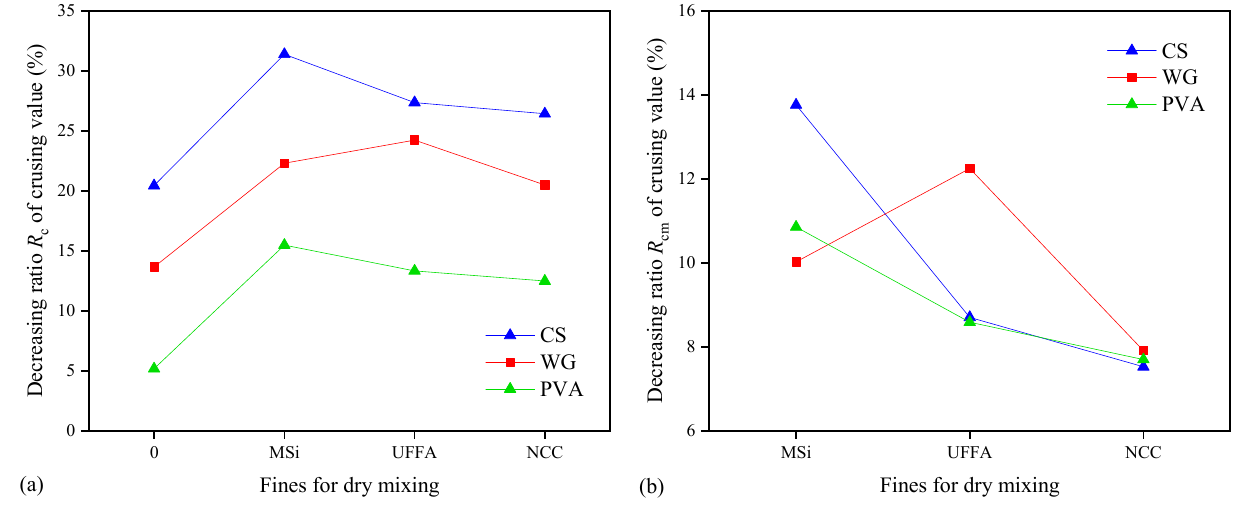
Figure 5. Relationship between the decreasing ratio ( a ) R c and ( b ) R cm of crushing value Q c with fines used for dry mixing when slurry coating with three kinds of solution.